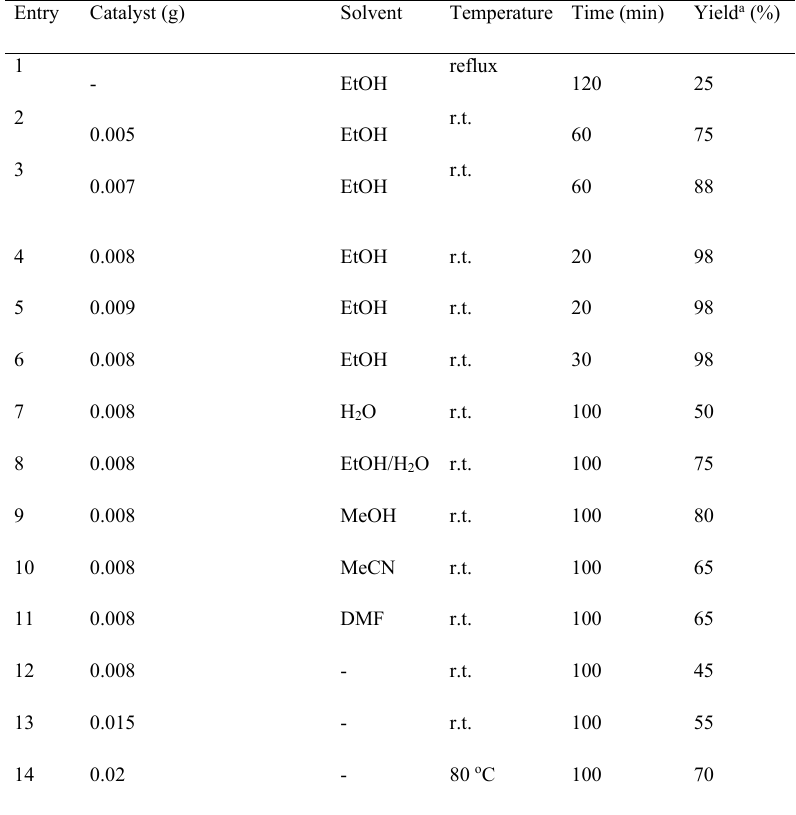
Table 1. Optimizing of the reaction conditions.